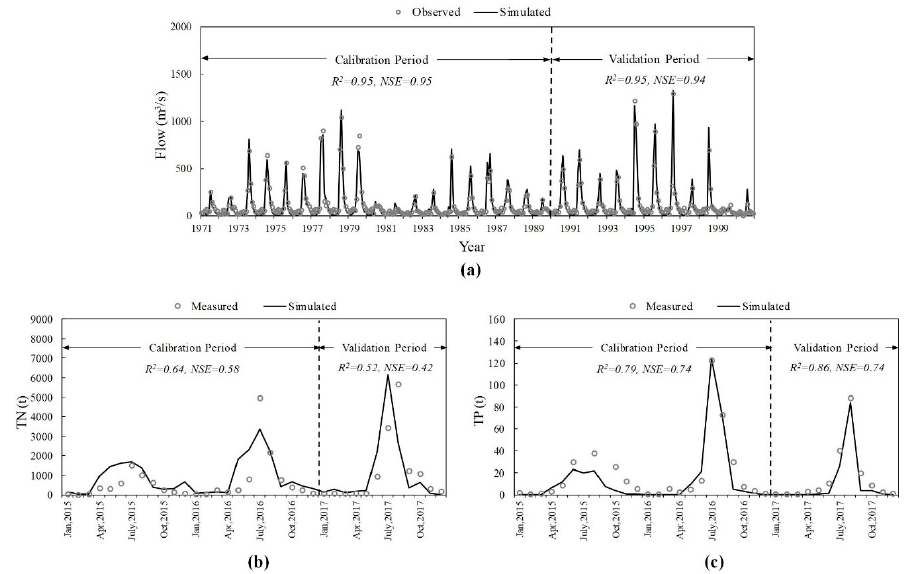
Figure 3. The Soil and Water Assessment Tool (SWAT) model calibration and validation results of ( a ) hydrological process of the Luanxian Station; ( b ) total nitrogen (TN) load; ( c ) total phosphorus (TP)